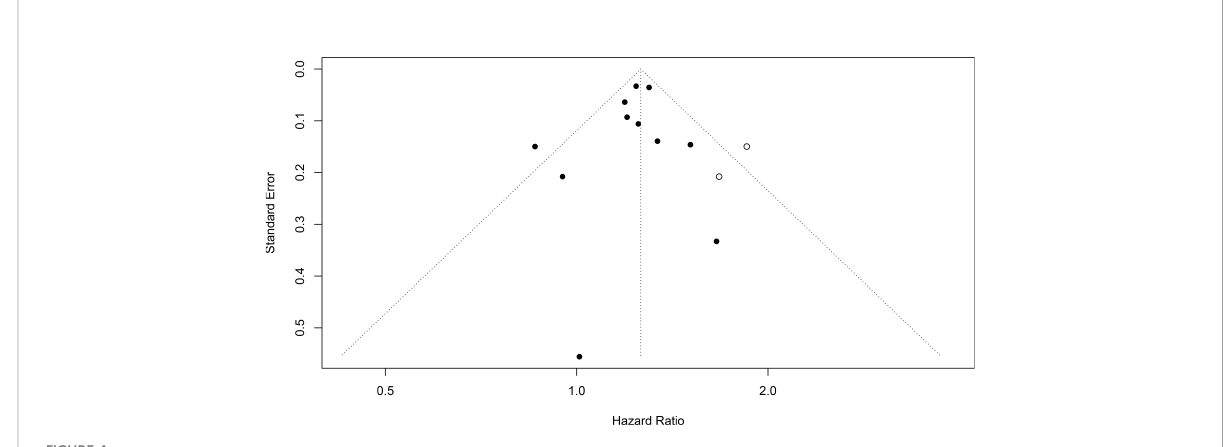
FIGURE 4 The result of the trim-and- fi ll